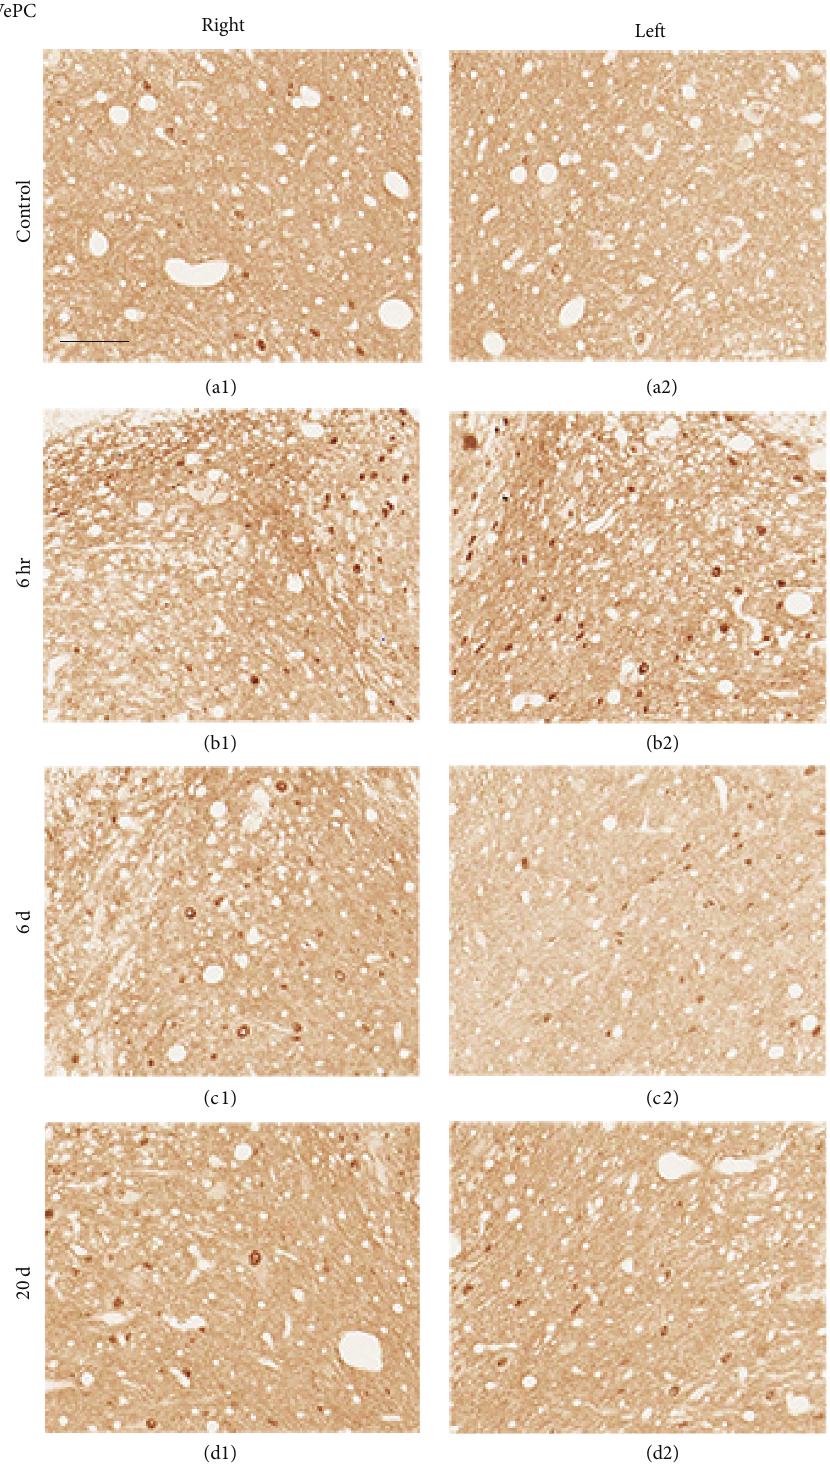
Figure 8: Representative photomicrographs showing c-Fos immunoreactivity in the MVePC (Bregma − 11.60mm) of rats that underwent cochleostomy at 1 and 3 hours and 6 and 20 days. Bilaterally increased c-Fos-positive cells were observed at 6 hours (b1 and b2), 6 days (c1 and c2), and 20 days (d1 and d2) compared to control (a1 and a2). (a1), (b1), (c1), and (d1): right side, (a2), (b2), (c2), and (d2): left side. Scale bar = 40 𝜇